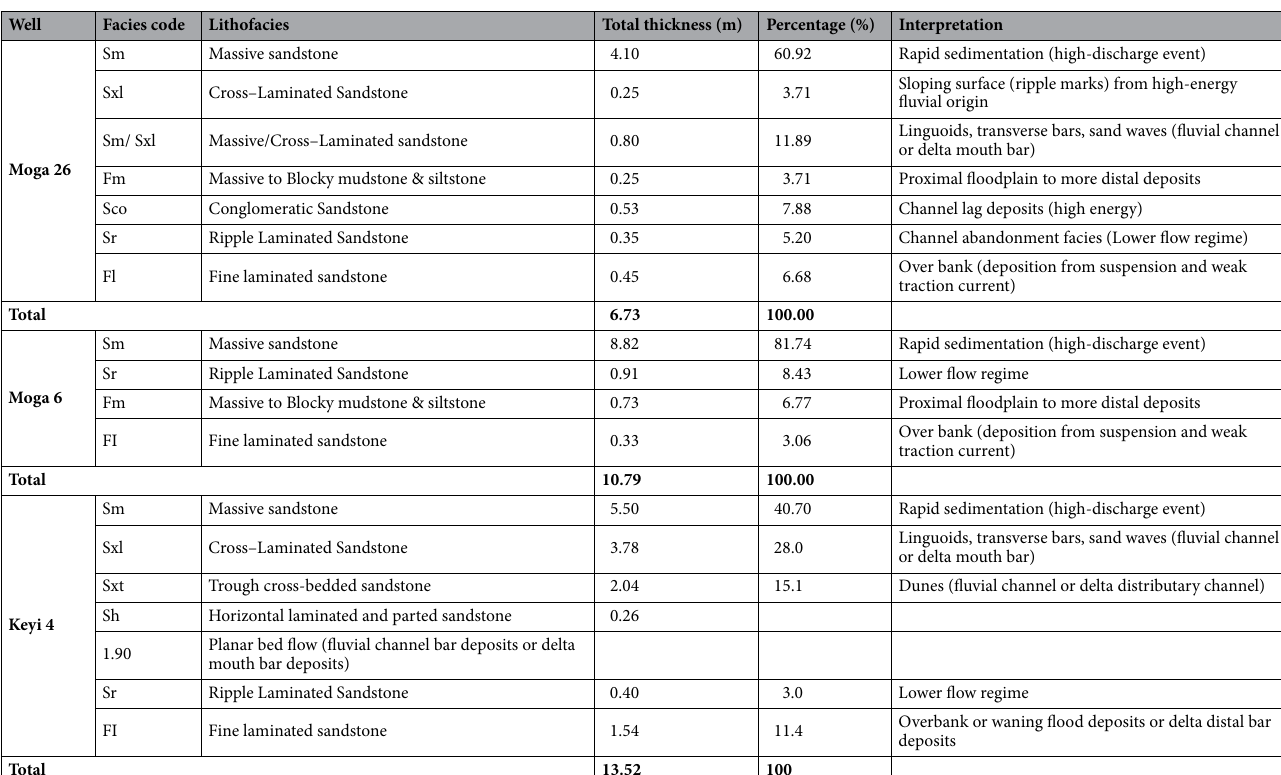
Table 2. Summary of the facies description presents in the studied core intervals. Facies codes (Sxl, Sm, Sr, Fm and Fl) according to Miall (1978, 1996 & 2006) classification.